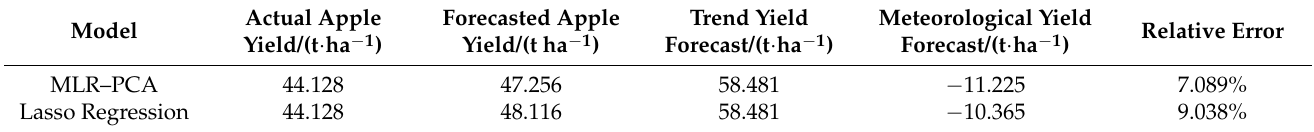
Table 8. Effect of yield